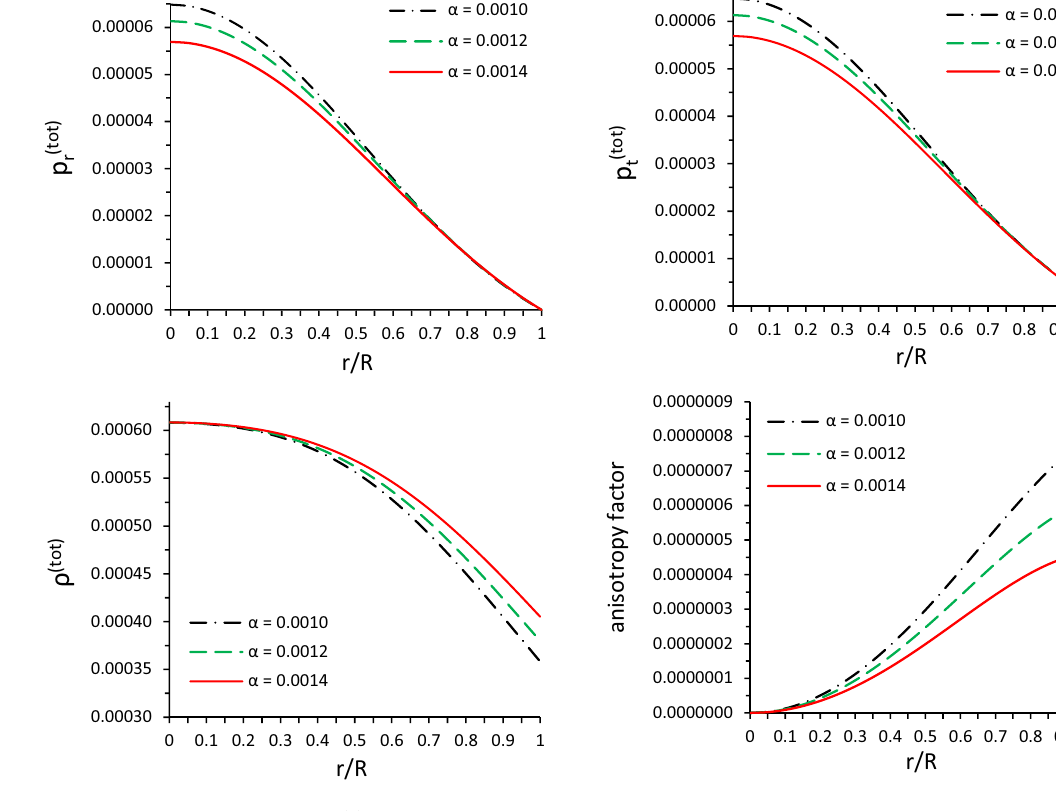
used numerical values for plotting these figures along with the same description of the curve for each compact object are same as used in Fig. (1)